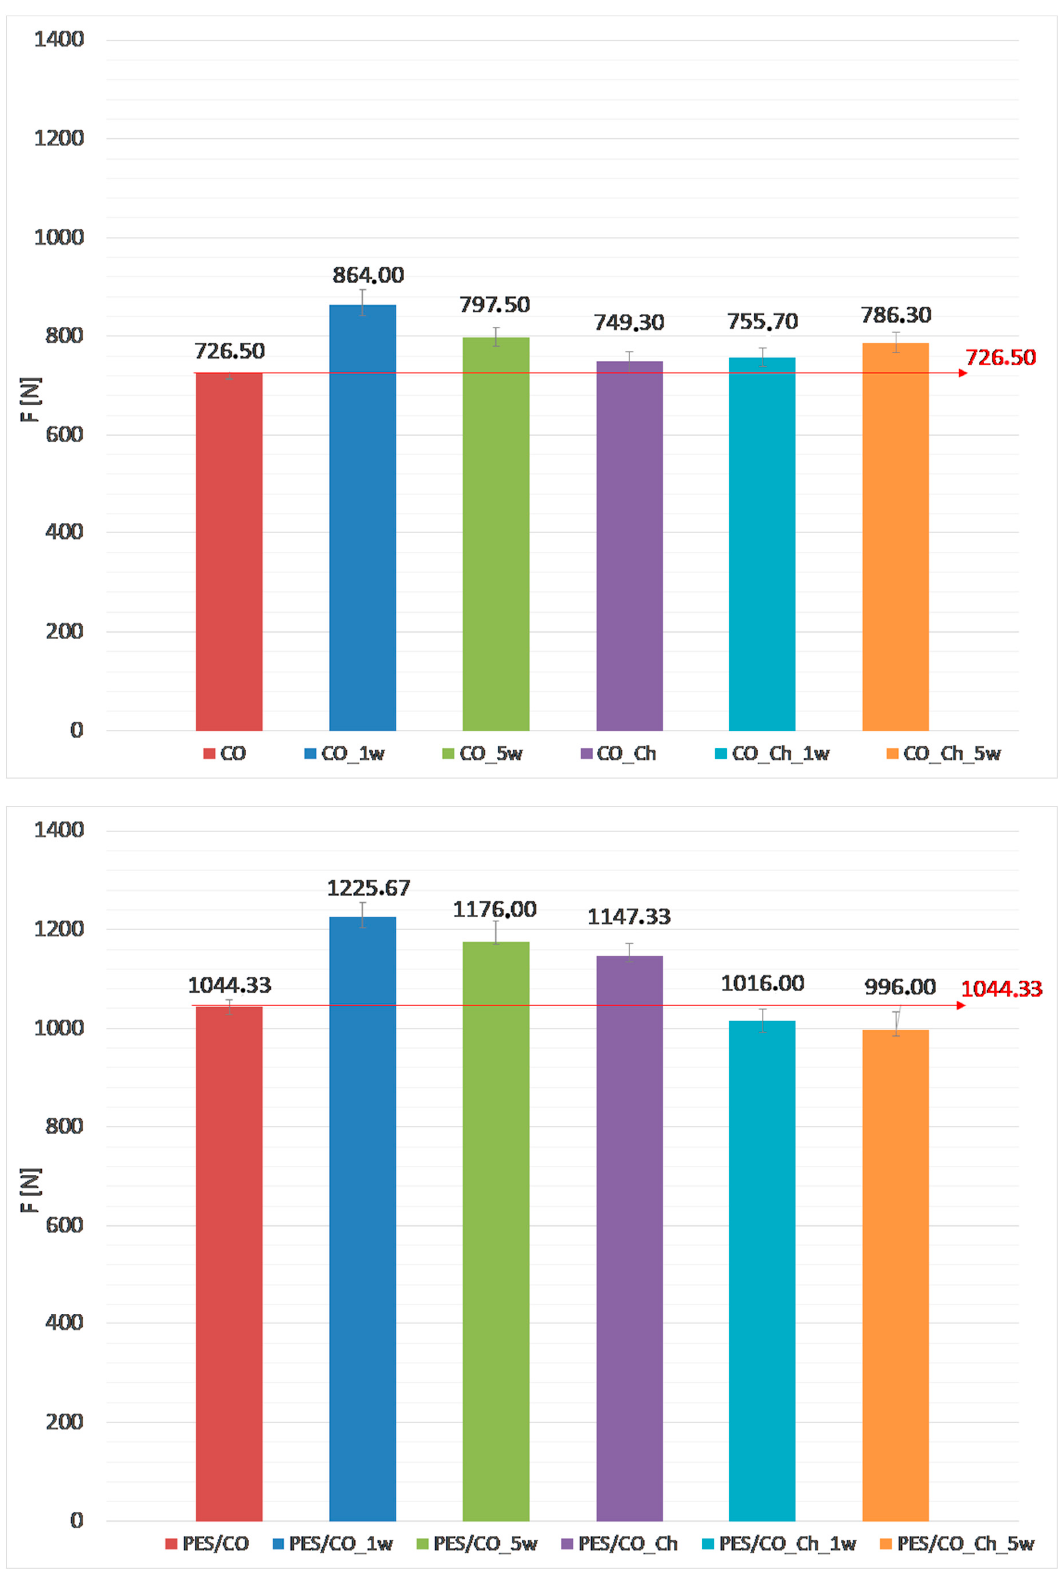
Figure 9. Breaking force, F [N] with interval of confidence (IC99%) of ( a ) cotton (CO), ( b ) polyester / cotton blend (PES / CO) fabric before and after washing